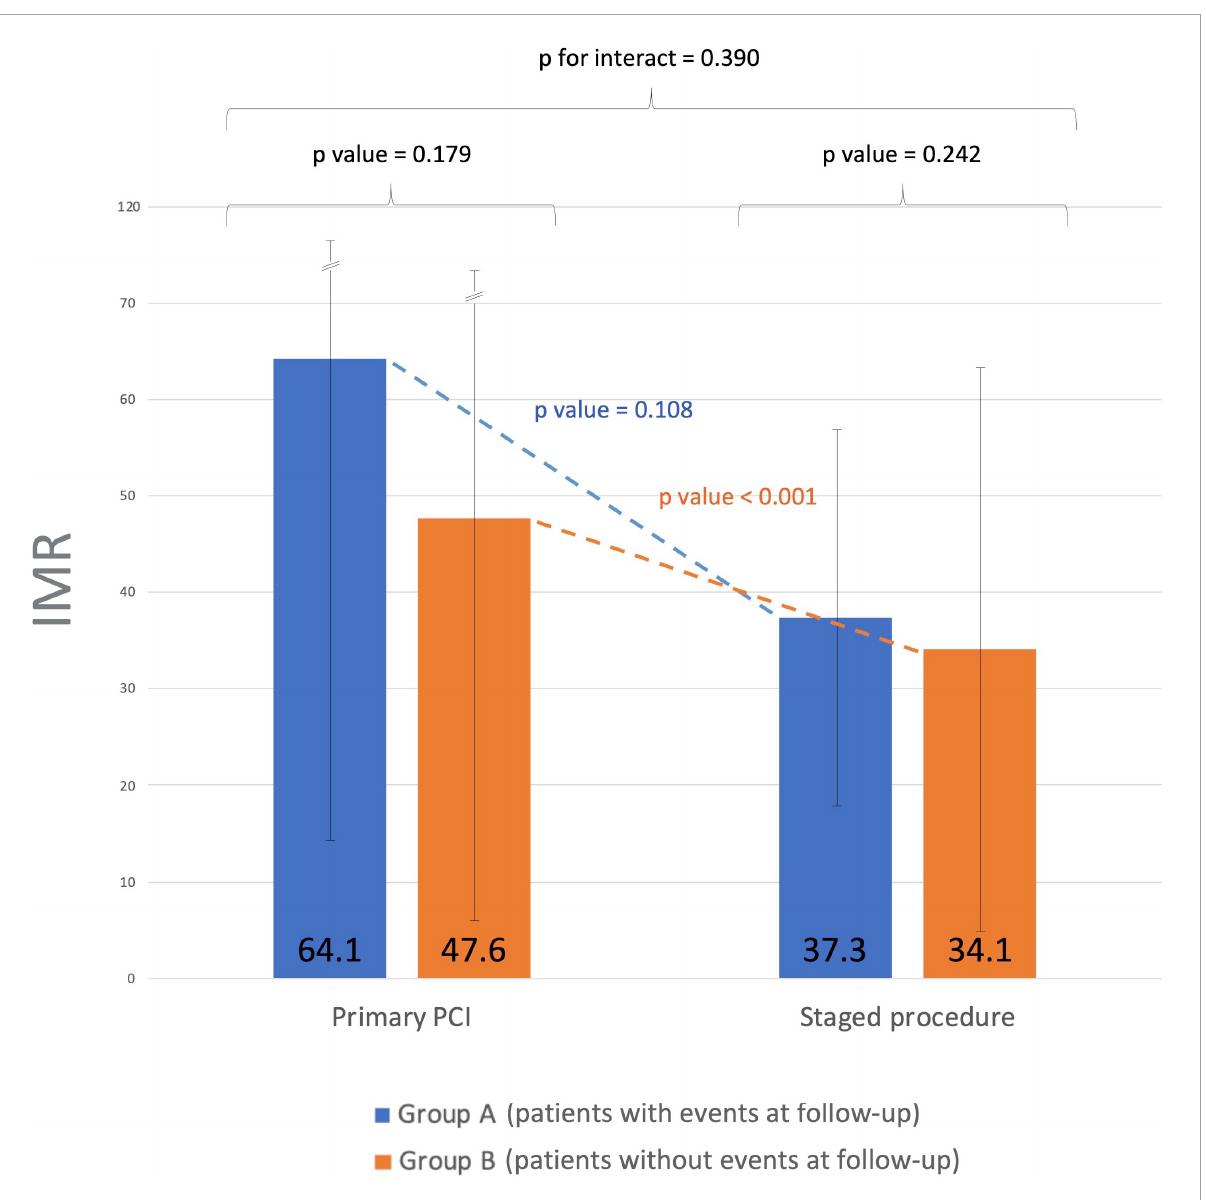
FIGURE2 Index of microvascular resistance (IMR) time course from primary to staged procedure. Group A: patients who experienced primary endpoints. Group B: primary endpoints event-free patients. No significant differences in IMR values were observed between the two groups after successful PPCI of the culprit lesion. The IRA IMR significantly improved in event-free patients between PPCI and staged procedure. IMR, index of microvascular resistance; PPCI, primary percutaneous coronary intervention; IRA, infarct-related artery.